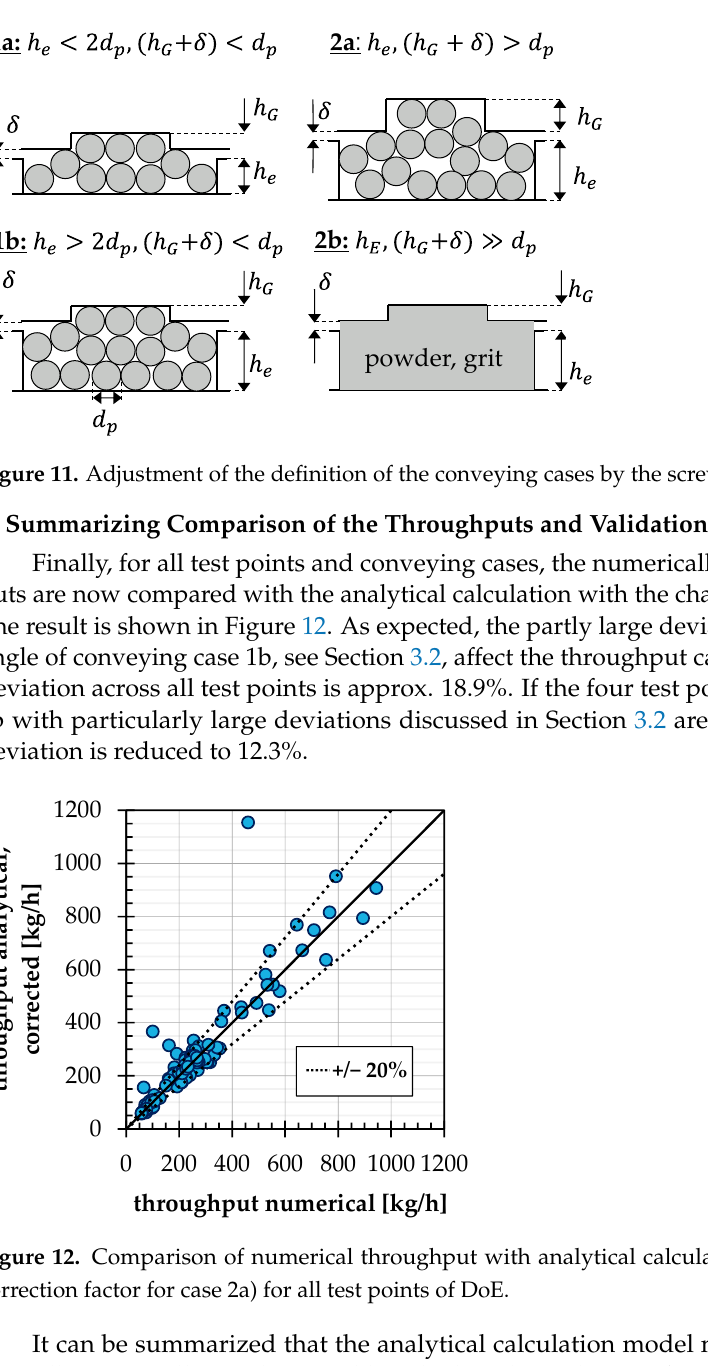
Figure 12. Comparison of numerical throughput with analytical calculation (with the use of the cor- rection factor for case 2a) for all test points of DoE.